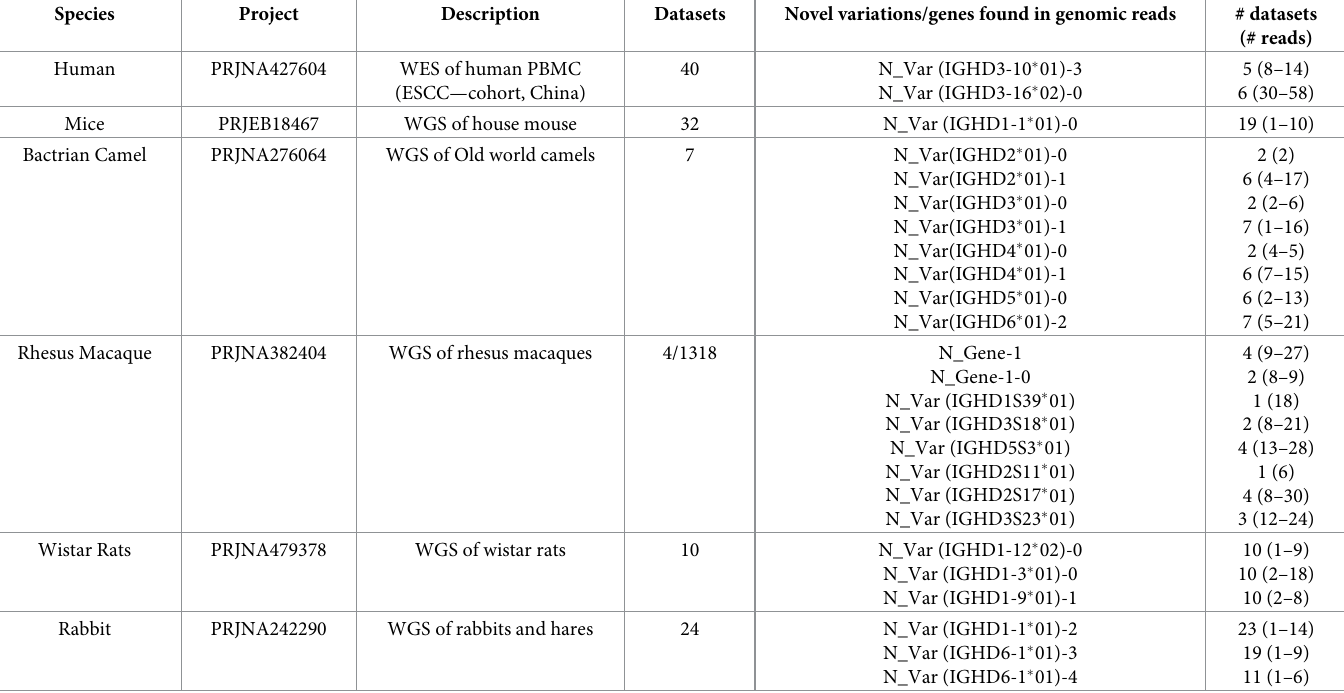
Table 5. Genomic data used for validating discovered D gene variations. The last column describes the number of datasets in which the novel sequences were found in genomic reads and the range of number of reads in which the sequences were found. For rhesus macaques, we chose only 4 datasets out of the 1318 in the NCBI project PRJNA382404 for